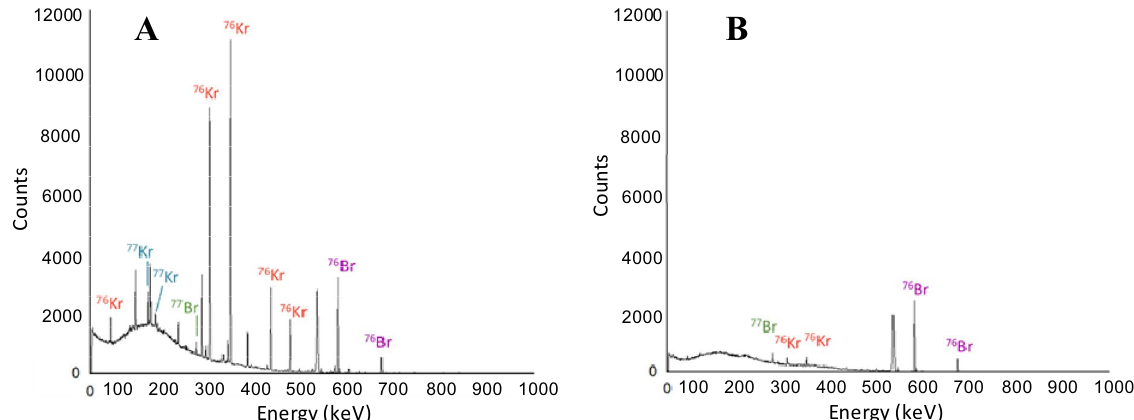
Figure 7. Gamma spectroscopy measurements (count time = 300 s) of stainless-steel trap 2 before ( A ) and after ( B ) the transfer of krypton gas to stainless steel trap 3. The successful movement of krypton gas due to changes in temperature is demonstrated by the decrease in counts of activity of 76 Kr and 77 Kr.